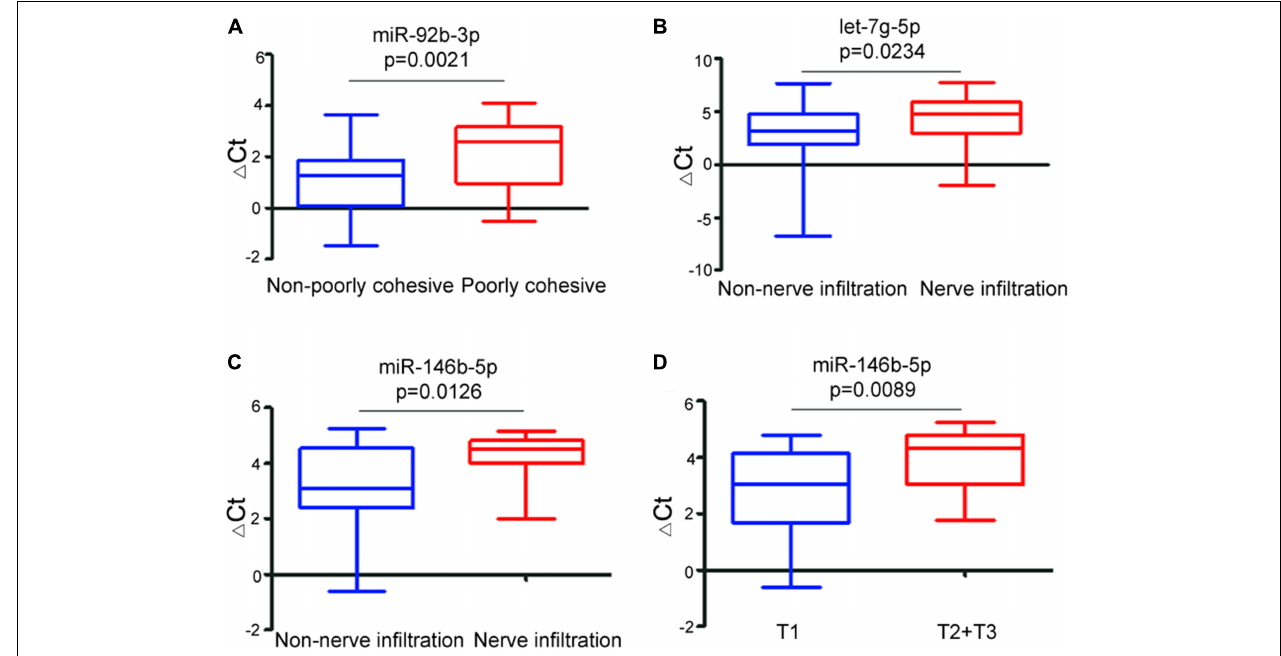
FIGURE 4 | Relationship between the (cid:49) Ct values of exosomal miRNA biomarkers and clinicopathological features of early-stage gastric cancer. Boxplot showing differential (cid:49) Ct values of miR-92b-3p between non-poorly cohesive and poorly cohesive GC patients (A) , differential (cid:49) Ct values of let-7g-5p (B) and miR-146b-5p (C) between non-nerve infiltration and nerve infiltration gastric cancer patients, and differential (cid:49) Ct values of miR-146b-5p between T1 stage and T2 + T3 stage gastric cancer patients (D) .